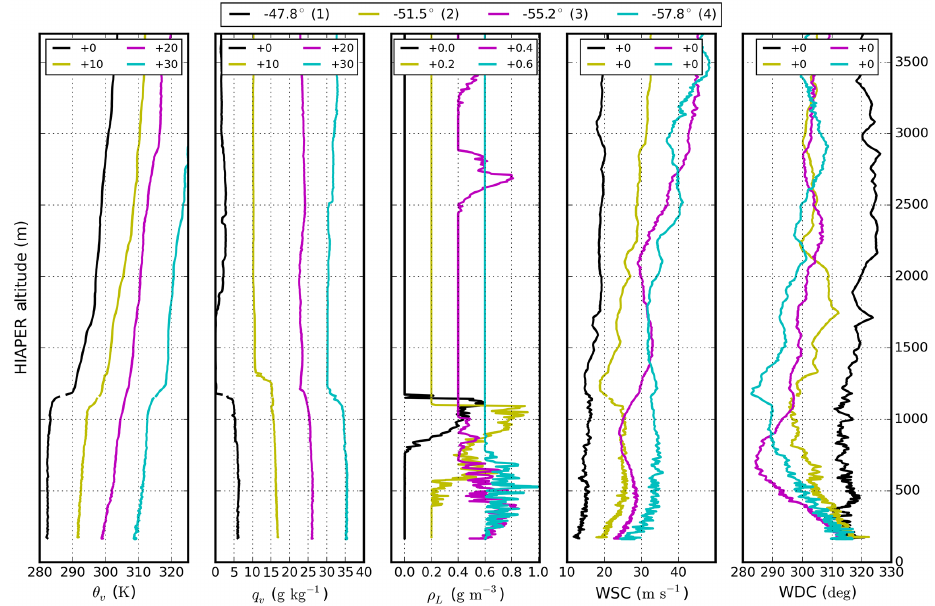
Figure 4. Profiles of thermodynamic variables within and above the boundary layer for RF06. From left: virtual potential temperature ( θ v ); specific humidity ( q v ); CDP liquid water content ( ρ L ); wind speed (WSC); and wind direction (WDC). The colors indicate the profile number and location (see top panel). Note that for display purposes, the values for some profiles have been offset by the amount indicated in the legend in each